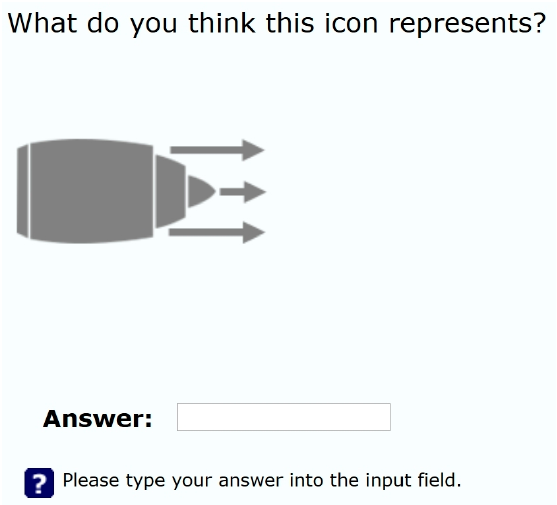
Figure 3. Example question from the first part of the online questionnaire.